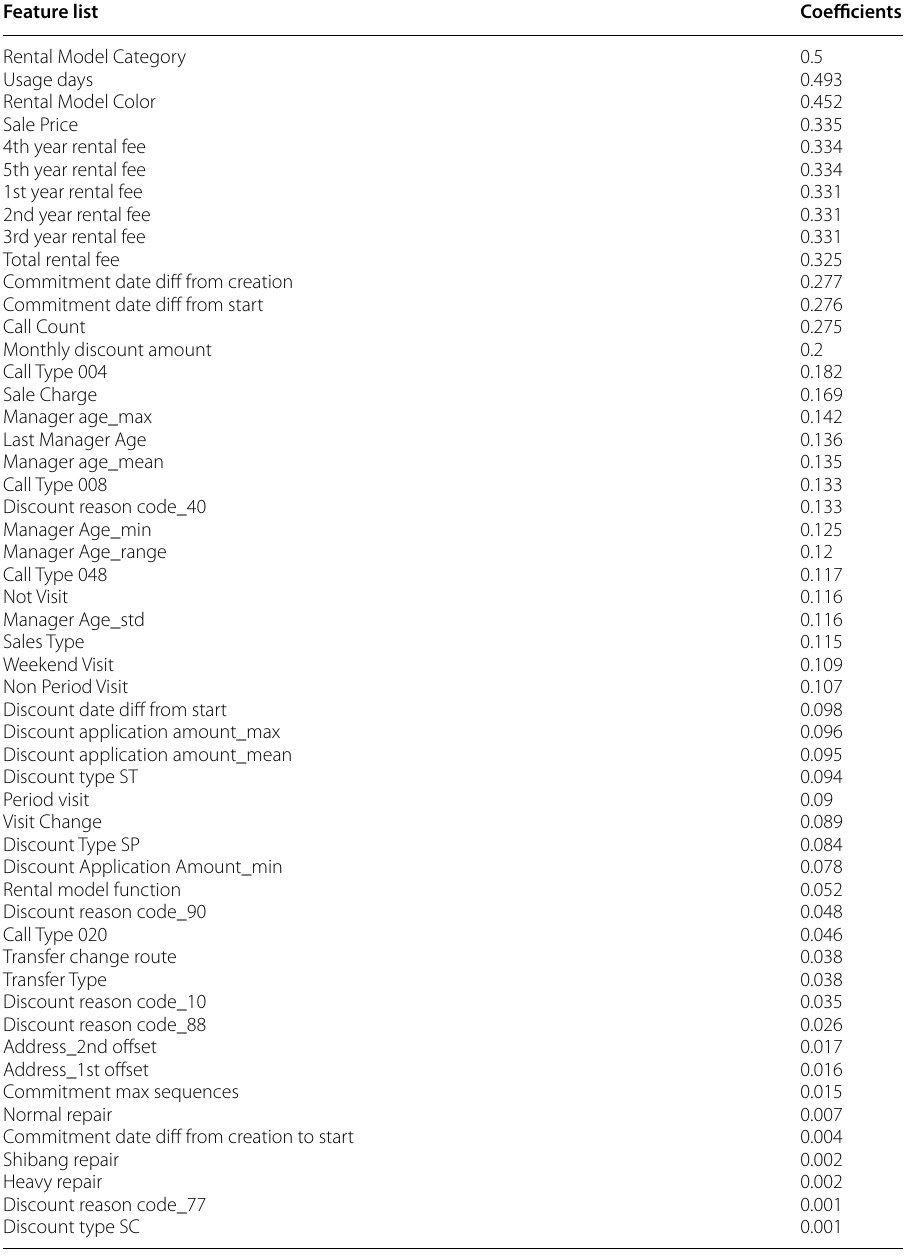
Table 7 The correlation coefficient between the finally selected features and the target class label Feature